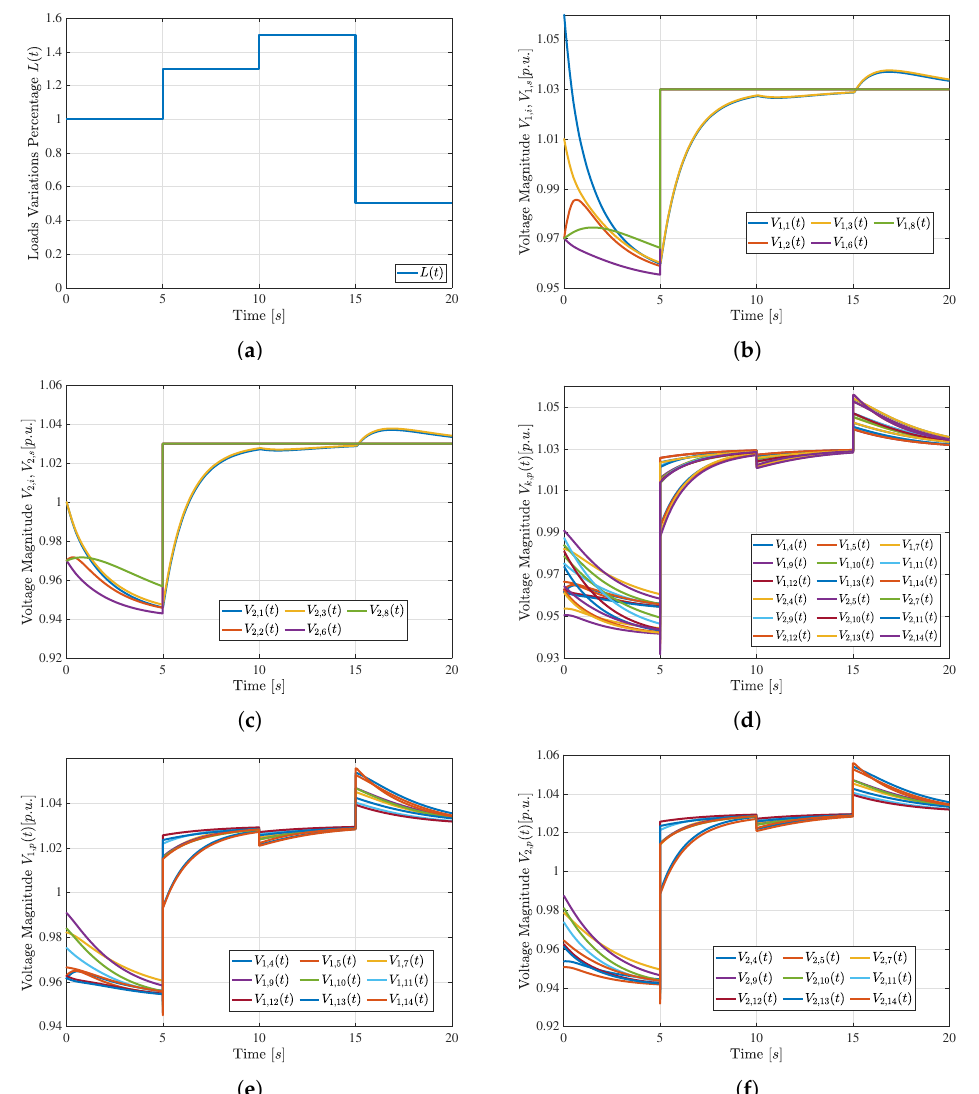
Figure 5. Cluster-Oriented Double-Layer Cooperative Control in Load Fluctuations scenario . Time history of: ( a ) Variable load profile L ( t ) . Percentage variation with respect to nominal value; ( b ) MG 1 Non-Pinner Generator bus and Pinner Generator bus voltages V 1, i , i ∈ N 1 g [ p . u . ] and V nom ( c ) MG 2 Non-Pinner Generator bus and Pinner Generator bus voltages V 2, i , i ∈ N 2 g [ p . u . ] and V nom , s = 2, 6, 8; ( d ) MMGs Voltage Values V k , p , ∀ k = 1,2, p ∈ N k c ; ( e ) MG 1 Capacitor bank bus 2, s voltages V 1, p , p ∈ N 1 c [ p . u . ] ( f ) MG 2 Capacitor bank bus voltages V 2, p , p ∈ N 2 c [ p . u . ]